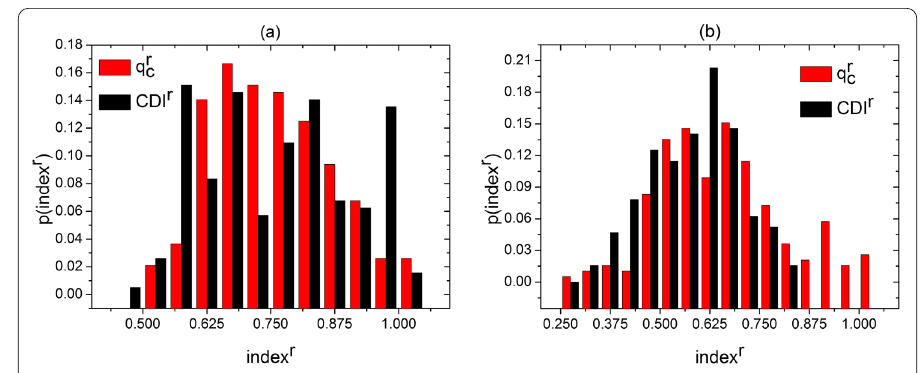
Figure 7 Scatter plot of the standard deviation of velocity and the standard deviation of q c . The result is based on the traffic data of Oct. 2015, Beijing. The standard deviation of velocity at each time is calculated by averaging the standard deviation of velocity of each day at the same time. The standard deviation of q c at each time is calculated based on q c of all days at the same